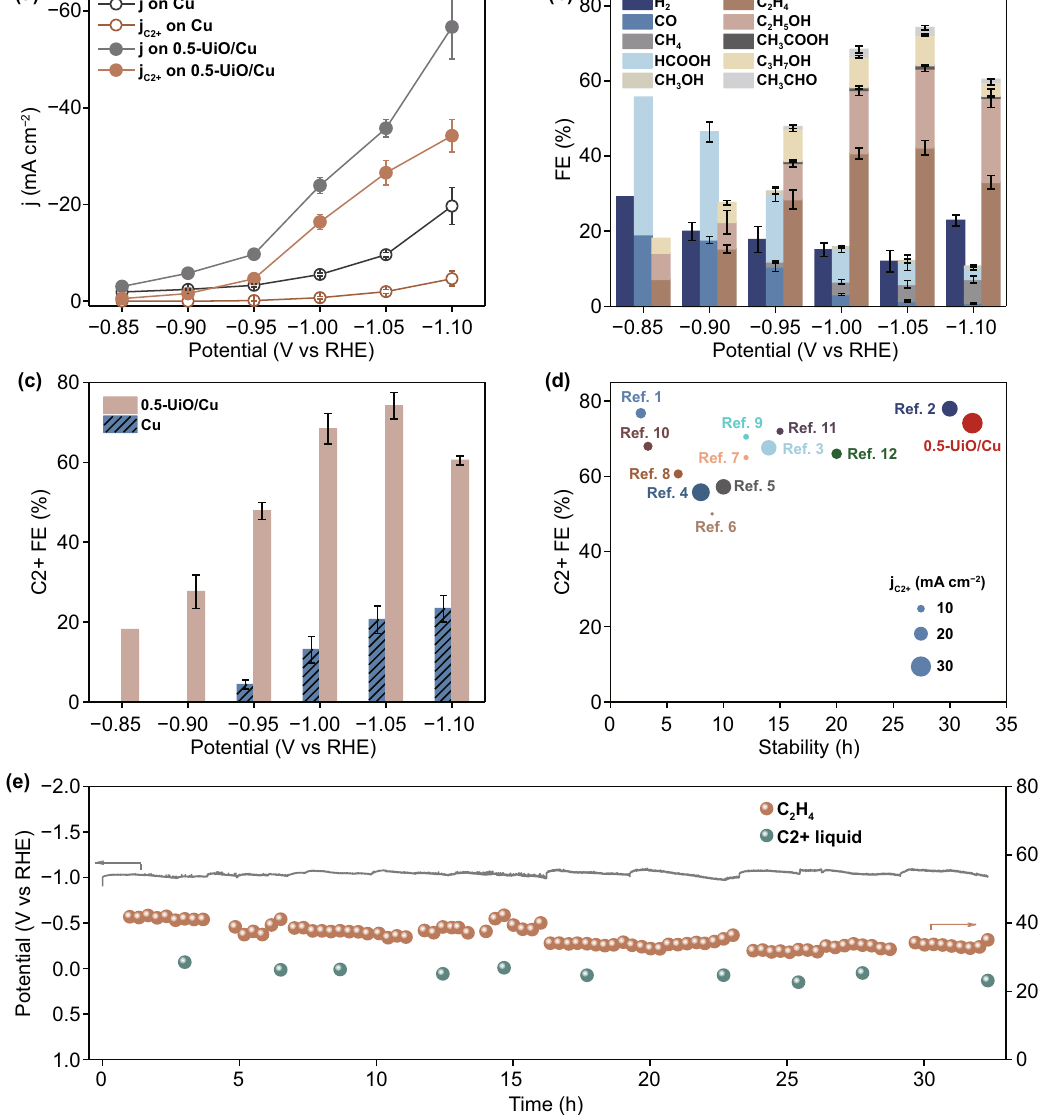
Fig. 2 a The geometric current densities and partial current densities for C 2+ products as a function of potential on Cu and 0.5-UiO/Cu. b FEs of CO 2 RR and HER products as a function of potential on 0.5-UiO/Cu. c FEs of C2+ products on Cu and 0.5-UiO/Cu as a function of potential. d Comparison of CO 2 RR performance (including FE and partial current densities for C2+ products and stability) on 0.5-UiO/Cu with state-of- the-art Cu-based catalysts (details shown in Table S2). e The chronopotentiometric potential-time curve (left axis) and FEs of C2+ products (right axis) for 0.5-UiO/Cu electrode at − 30 mA cm −2 during a stability test of 32